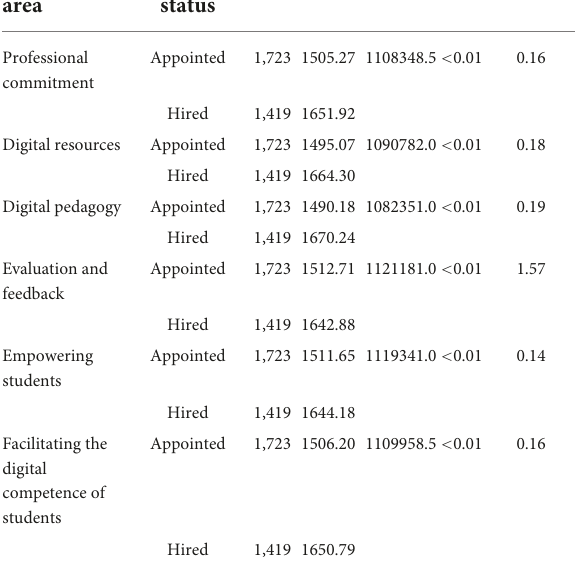
TABLE 4 Results of Mann-Whitney U for the areas of digital teaching competence with effect size according to employment